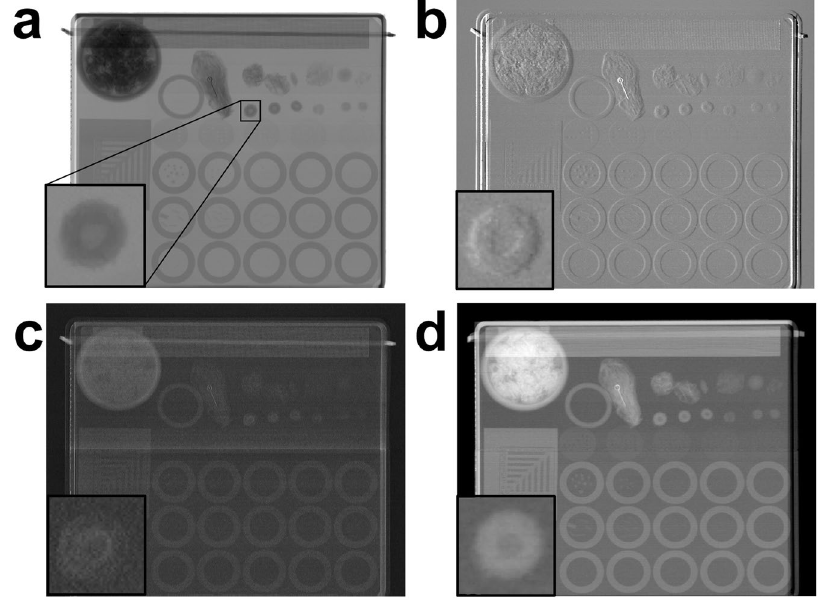
Figure 3. Example of a low x-ray dose scan. The three retrieved images of the mammographic Ackermann sample at low x-ray dose: ( a ) absorption, ( b ) differential phase, ( c ) dark-field images, and ( d ) phase map. The inset in the bottom left corner of each panel is a 5 × zoom of the detail highlighted by the small square in panel (a) (sample size 10 × 11 cm 2 ; the sample was scanned along the horizontal